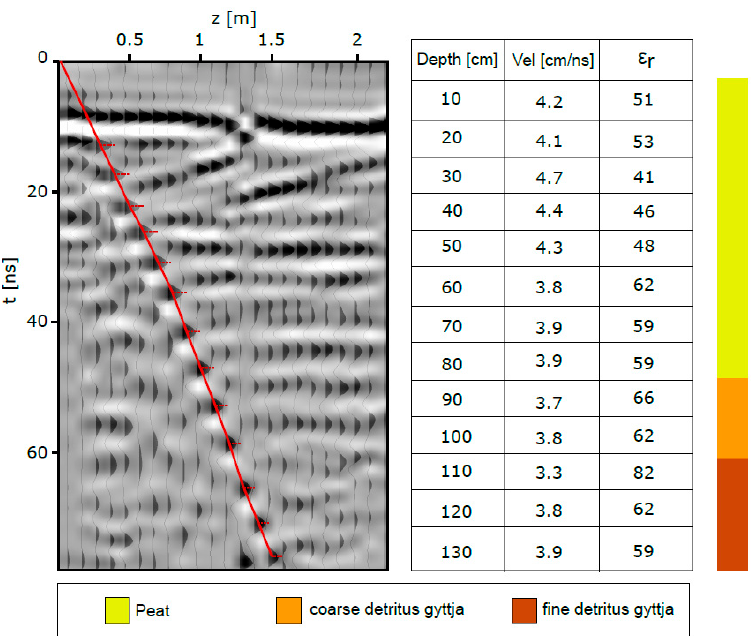
Figure 5. Field data of guided waves with picked traveltimes (red line). Z is the depth of the lower waveguide end in the hole. The table reports the GPR velocities and dielectric permittivity calculation from the guided wave measurements at core I.8. The stratigraphy is indicated with different colors for comparison.